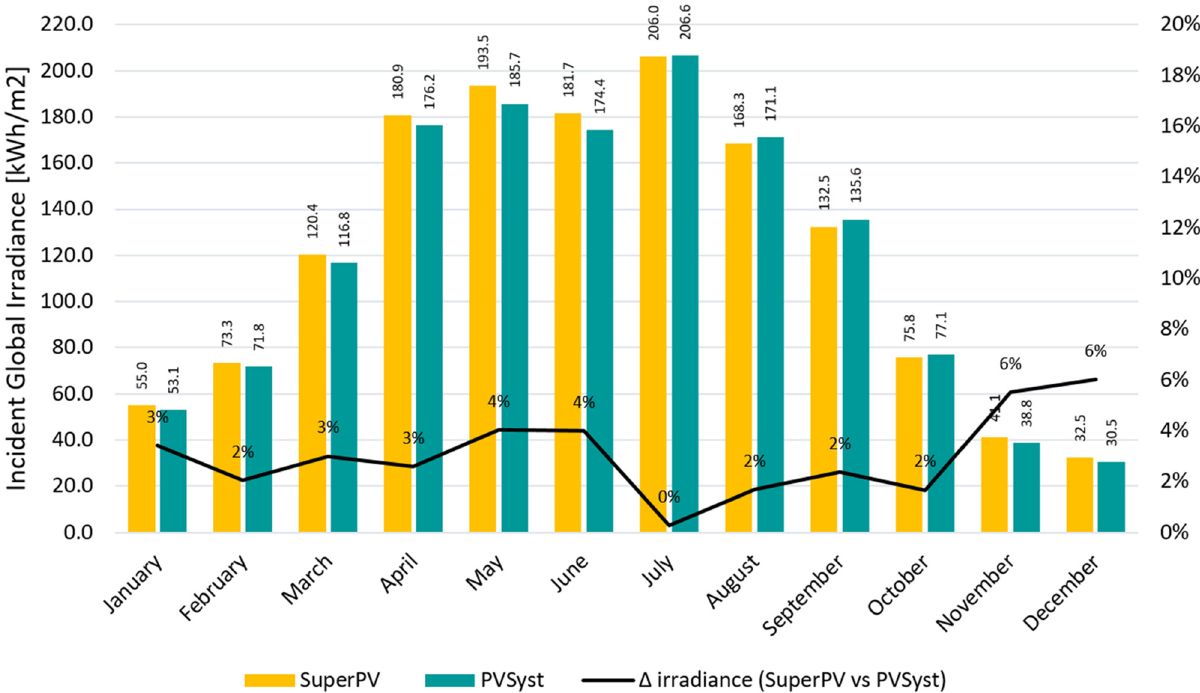
Fig. 10. Incident Global Irradiance on PV